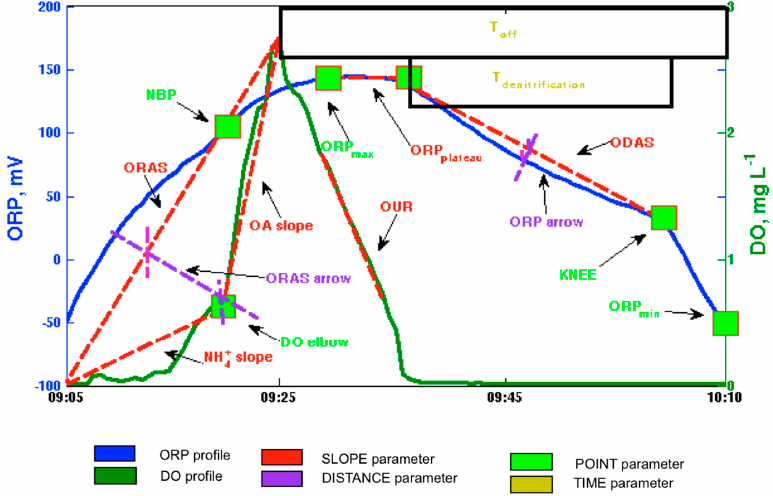
Figure 1. Representation and meaning of the 16 parameters obtained from the DO and ORP profiles (in order to clarify their meaning they have been grouped into four categories).